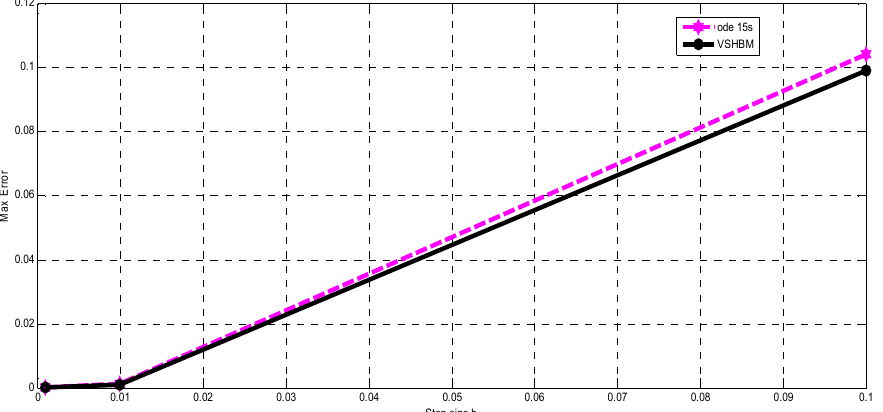
Figure 7. Maximum error comparison for with constant step size h.